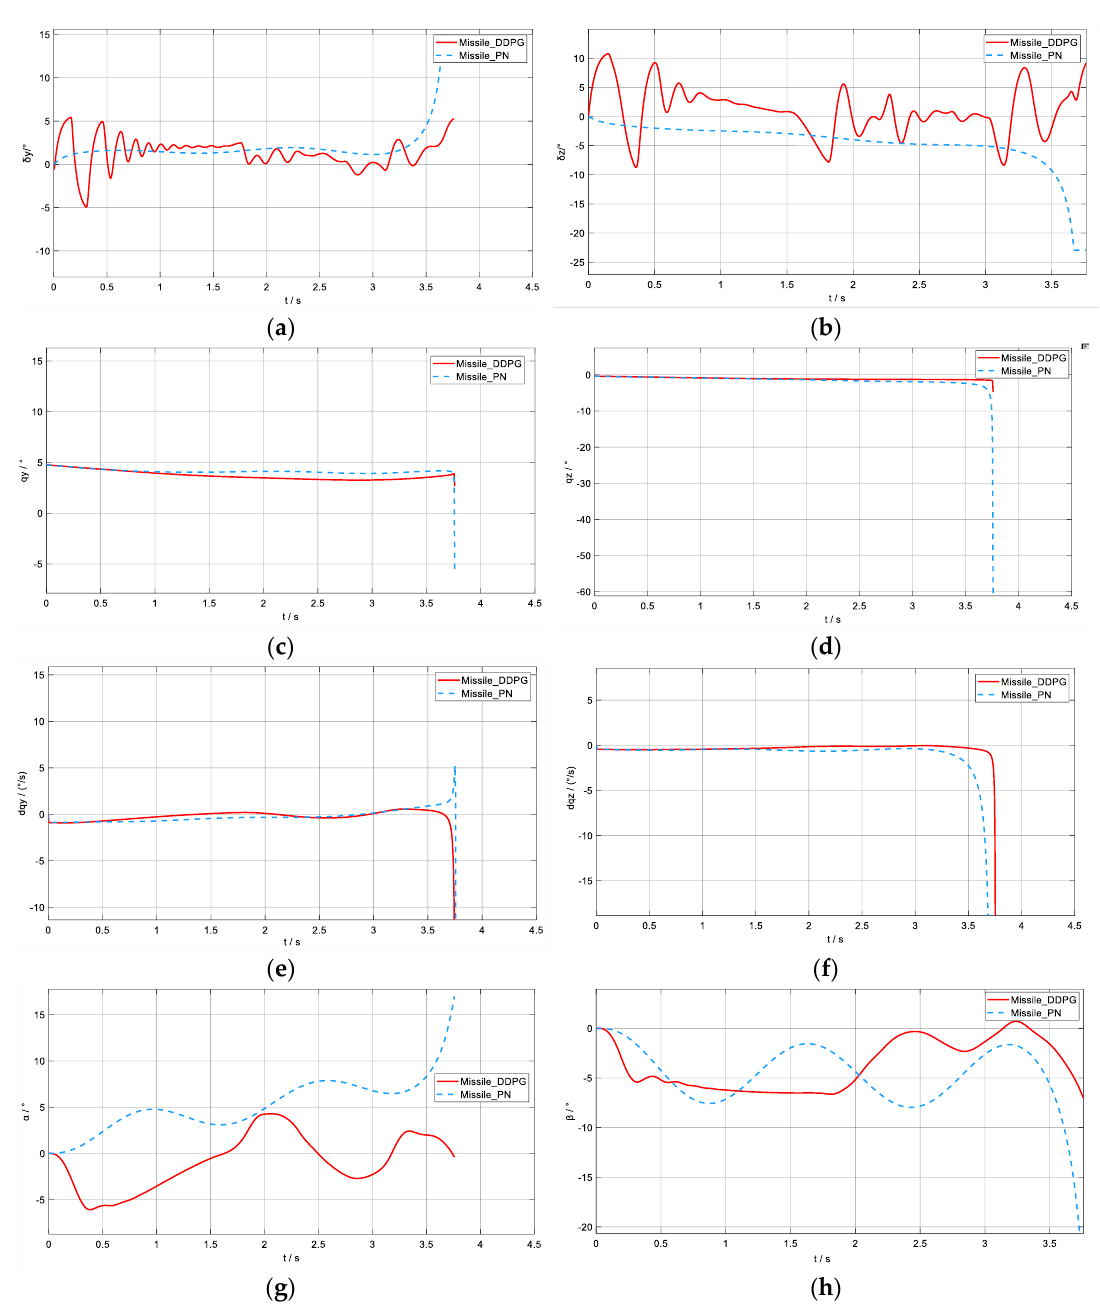
Figure 5. Ballistic curve: ( a ) and ( b ) are the lateral and elevated fin − deflection curves; ( c ) and ( d ) are the line − of − sight angles (y and z directions); ( e ) and ( f ) are the line − of − sight angular velocities (y and z directions); ( g ) and ( h ) are the angle − of − attack curve and sideslip − angle curve, respectively (Scenario